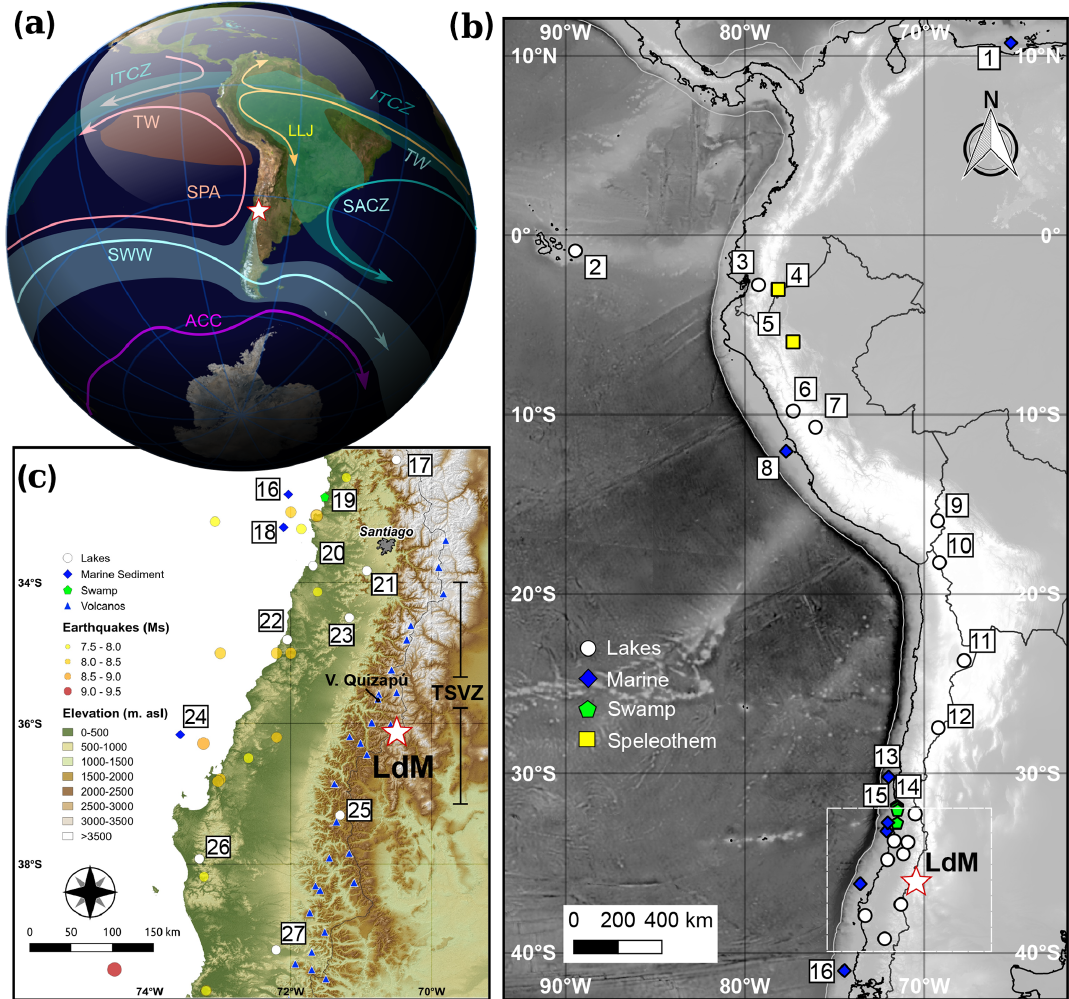
Figure 1. Regional context of LdM in the southern Central Andes of central Chile. (a) Schematic map of the principal low-level atmospheric flows over South America. SWW – southern westerly wind; SPA – southeast Pacific anticyclone; TW – trade winds; ITCZ – Intertropical Convergence Zone; LLJ – subtropical low-level jet stream; SACZ – South Atlantic Convergence Zone; and ACC – Antarctic Circumpolar Current. Light green (tropical rainfall), orange (stratocumulus and cold SST) and light blue (midlatitude precipitation) areas represent the influence of atmospheric precipitation associated with each forcing, modified from Garreaud et al. (2009). The maps (b, c) show the main locations of the paleoclimate records discussed in the text with a digital elevation model (STRM30; Becker et al., 2009; Smith and Sandwell, 1997). White circles are lacustrine records: 2 – El Junco lake (Zhang et al., 2014); 3 – L. Pallcacocha (Moy et al., 2002); 6 – L. Queshquecocha (Stansell et al., 2013); 7 – L. Pumacocha (Bird et al., 2011); 9 – L. Titicaca (Fornace et al., 2014); 10 – L. Chungará (Moreno et al., 2007); 11 – L. Miscanti (Valero-Garcés et al., 1996, 1999); 12 – L. Negro Francisco (Grosjean et al., 1997; Valero-Garcés et al., 1999); 17 – L. Chepical (de Jong et al., 2013); 20 – L. Matanzas (Villa-Martínez, 2002); 21 – L. Aculeo (Jenny et al., 2002, 2003); 22 – L. Vichuquén (Frugone-Álvarez et al., 2017); 23 – L. Tagua Tagua (Valero-Garcés et al., 2005); 25 – L. Laja (Urrutia et al., 2010); 26 – Lanalhue and Lleu Lleu lakes (Stefer et al., 2010); and 27 – Pichilafquén lake (Jara and Moreno, 2014). Green pentagons represent coastal peat swamp records: 14 – Ñague and Quereo (Maldonado and Villagrán, 2002; Villagrán and Varela, 1990); 15 – Palo Colorado (Maldonado and Villagrán, 2006); and 19 – Quintero ((Villa-Martínez and Villagrán, 1997). Blue diamonds represent marine records: 1 – Cariaco Basin ODP1002 core (Haug et al., 2001); 8 – SO147-106KL (Rein et al., 2005); 13 – GEOB7139-2 (De Pol-Holz et al., 2007); 16 – ODP 1233 and GeoB3313-1 cores (Muratli et al., 2010a, b; Lamy et al., 2002); 18 – GEOB3302-1 and GIK17748-2 cores (Kim et al., 2002); and 24 – ODP 1234 and ODP 1235 cores (Muratli et al., 2010a, b). Yellow squares represent speleothem records: 4 – Santiago cave (Mosblech et al., 2012); and 5 – Tigre Perdido cave (van Breukelen et al., 2008). The software used to build the map was QGIS